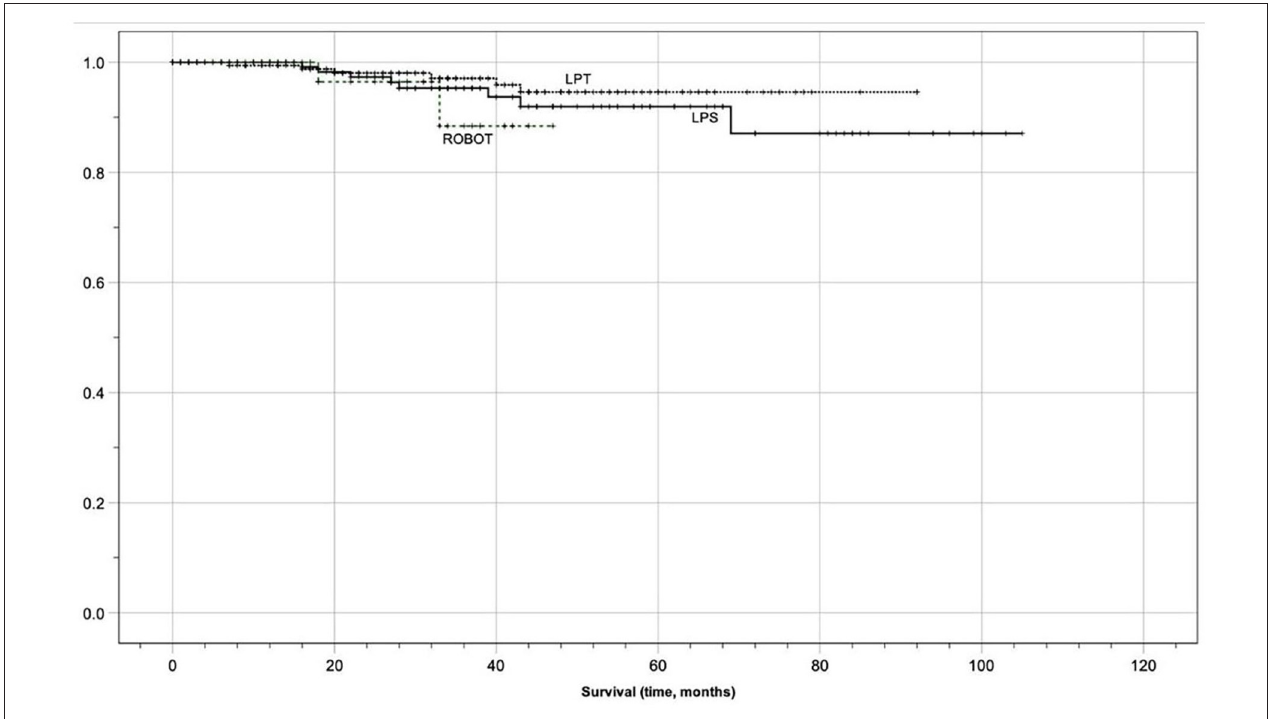
FIGURE 1 | Kaplan meier survival analysis (overall survival).